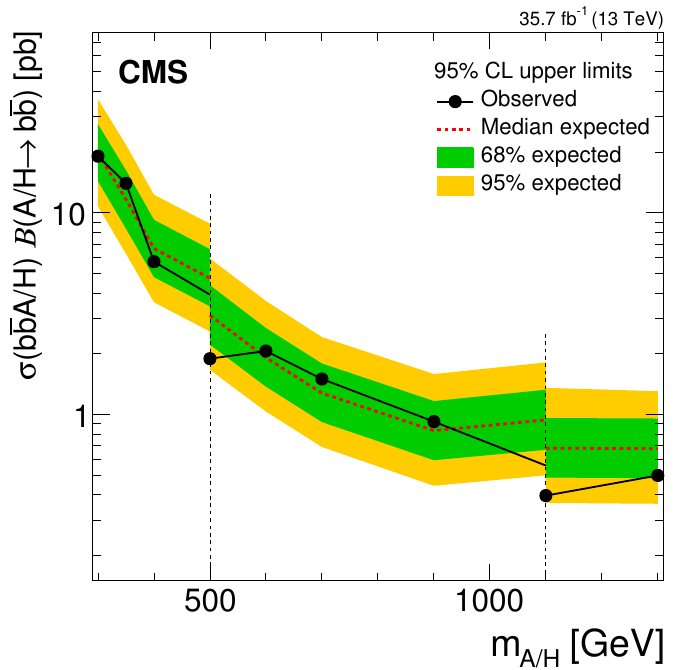
Figure 6 . Expected and observed upper limits on (cid:27) (pp ! bA = H + X) B (A = H ! bb) at 95% CL as a function of the Higgs boson mass m A = H . The inner and the outer bands indicate the regions containing 68 and 95%, respectively, of the distribution of limits expected under the background- only hypothesis. The dashed horizontal lines illustrate the borders between the three subranges in which the results have been